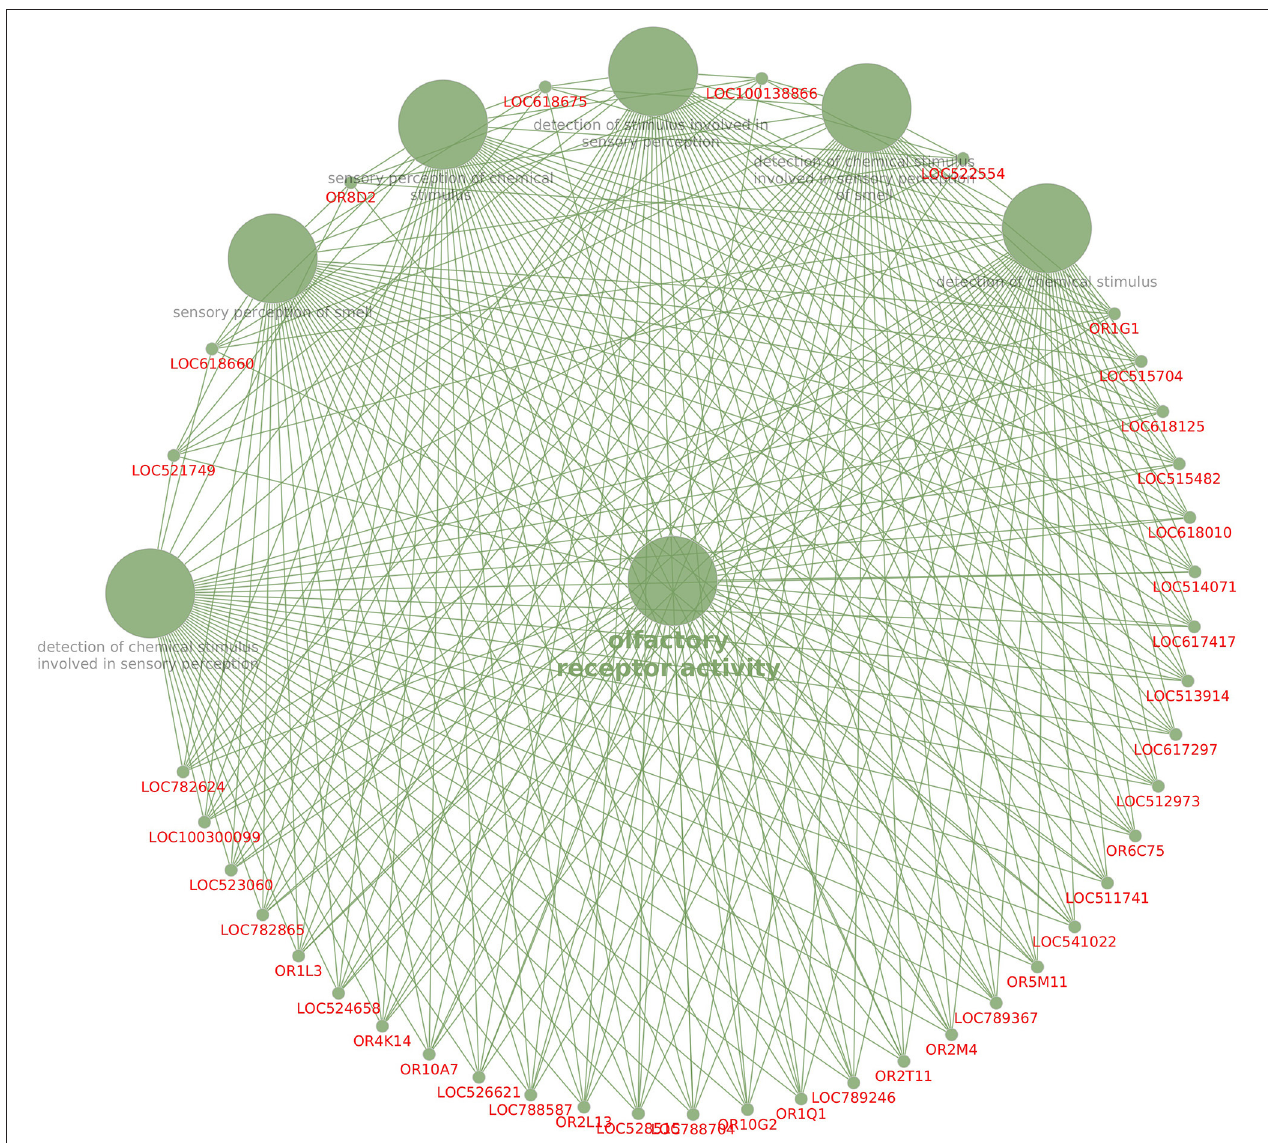
FIGURE 4 | Interaction between the dysregulated genes involved in the olfactory